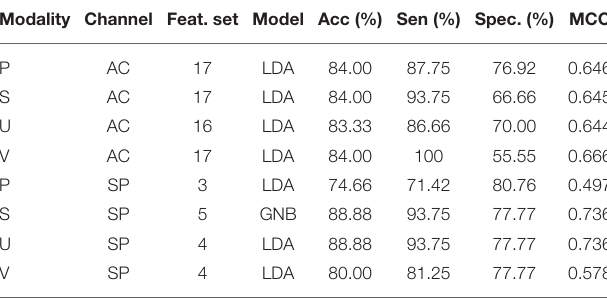
TABLE 10 | Best performance offered by individual modalities.